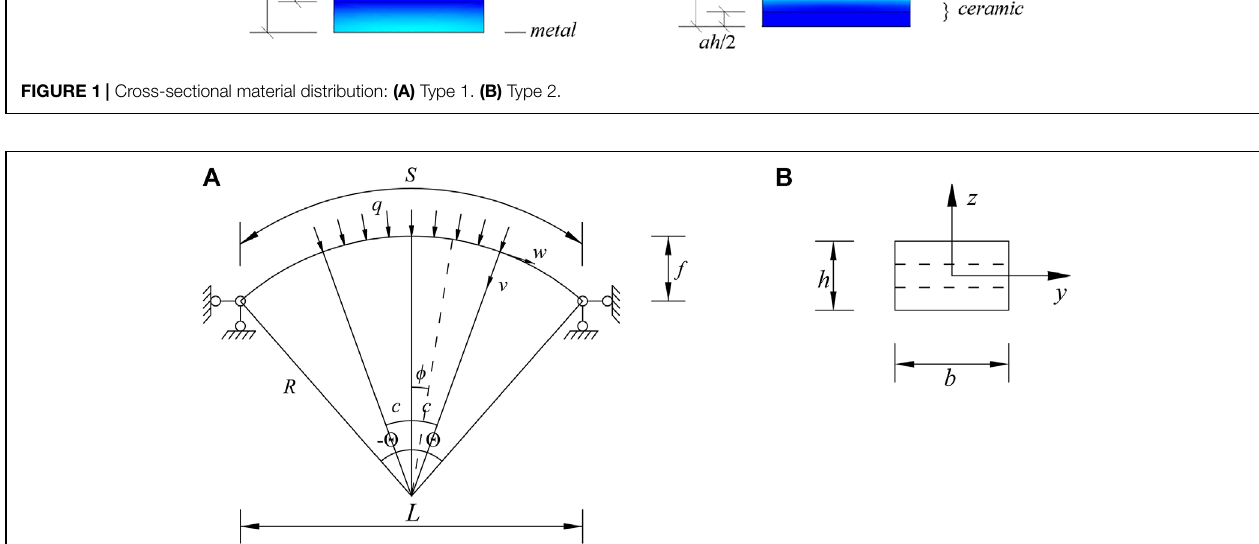
FIGURE 2 | Mechanical model of the pin-ended FGM arches: (A) Pin-ended FGM arch. (B)